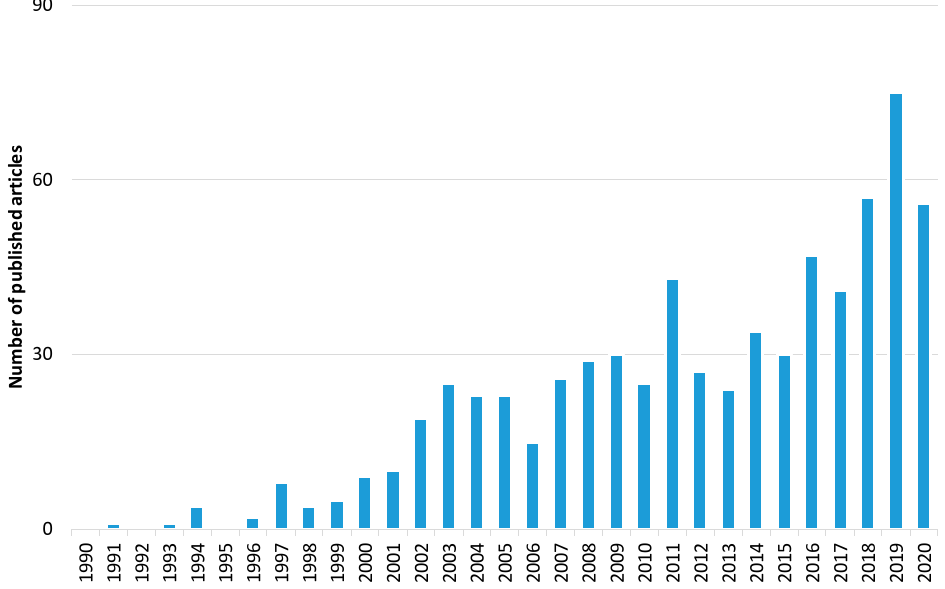
Figure 6. The number of published articles per year related to forest fire detection in the imaging research area. Data retrieved from Web of Science [134] for dates between 1990 to October 2020.